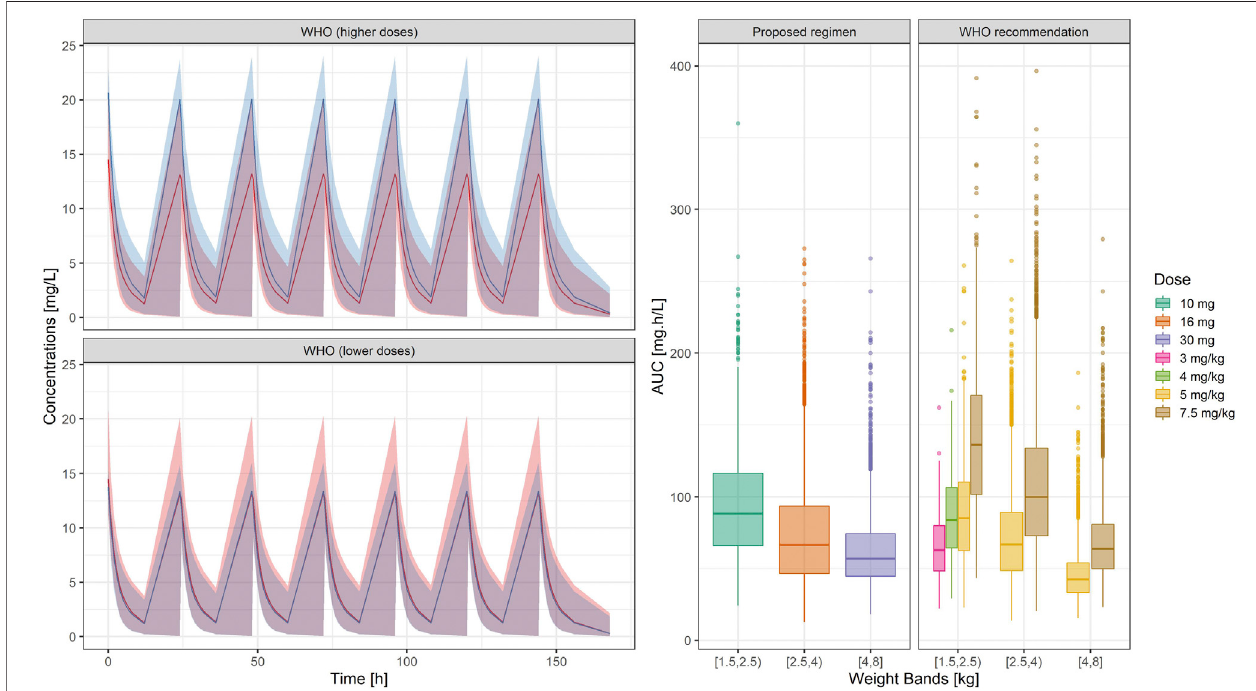
FIGURE 5 | (Left) Predicted gentamicin concentration vs. time pro fi le in sepsis patients aged between 0 and 59 days. Each panel compares the pharmacokinetic pro fi les inthetargetpopulationafter theproposedregimen(red) withthoseobtainedafterhigher (upperpanel)andlowerdoses(lowerpanel) oftheWHOrecommended regimen (blue).Solid line depicts the median pro fi le; shaded area represents the 90% prediction intervals. Time 0 is used asreference for the fi rst dose (Right) Systemic exposure,expressedasareaundertheconcentrationvs.timecurve.Hingesrepresent25 th and75 th percentiles(respectively,Q1andQ3),whiskersrepresentQ1 − 1.5IQR and Q3 + 1.5IQR, respectively, where IQR is the interquartile range. All the subjects outside this range are represented by the dots ( N (cid:1) 9,994). Overall, the weight-banded regimens result in similar exposure ranges, with a slight trend to lower values in the highest weight band.